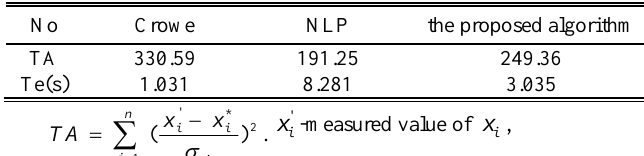
Table 6. Compare results of Crowe, NLP and the proposed